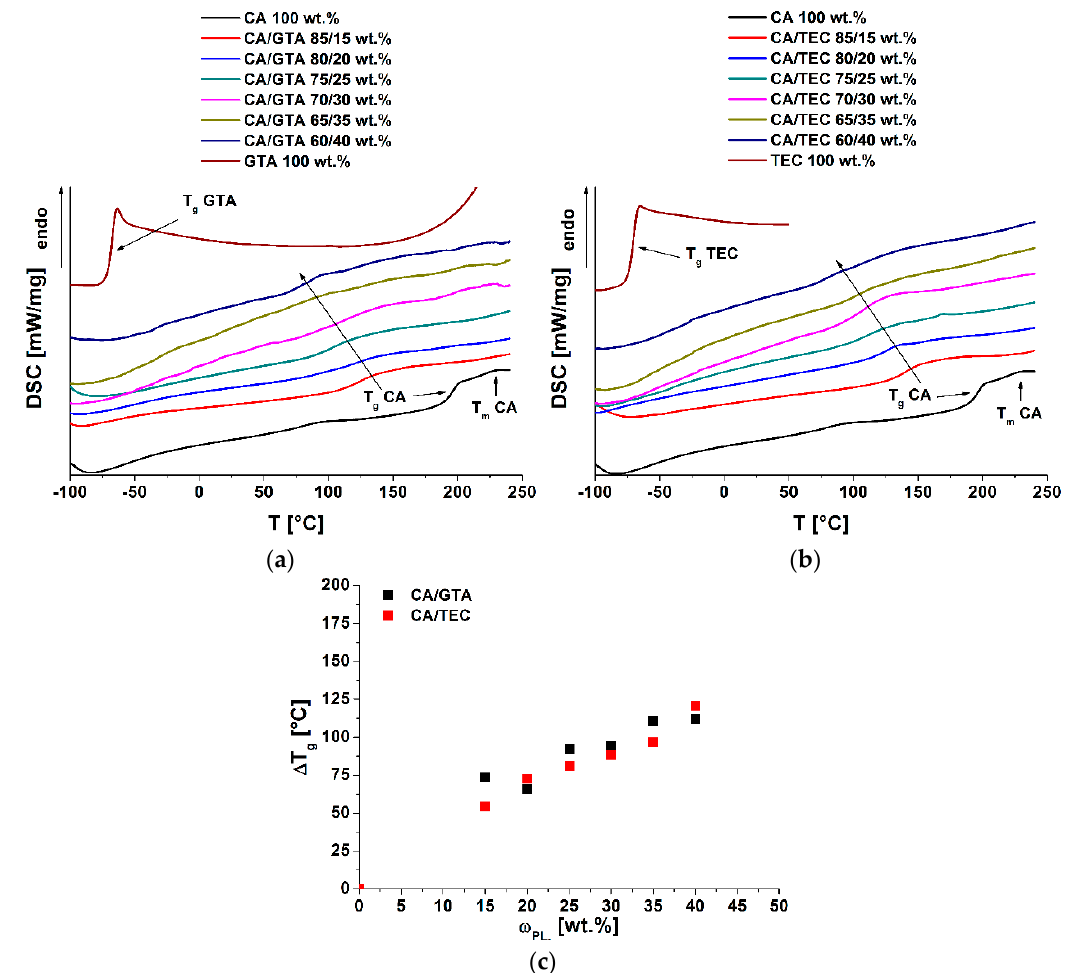
Figure 2. Second heating run of the corresponding samples ( a ) samples with GTA and ( b ) samples with TEC as plasticizer in cellulose acetate. ( c ) Glass transition temperature depression of GTA- and TEC-plasticized CA.